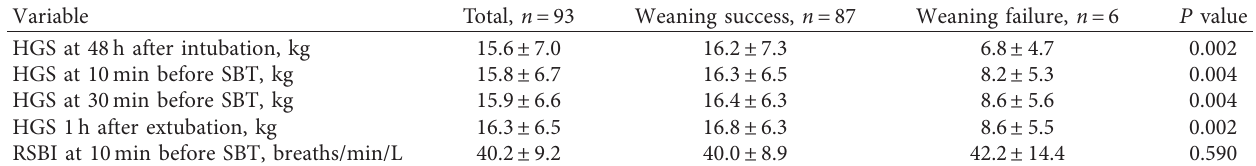
Table 2: Comparison of handgrip strength and rapid shallow breathing index between weaning success and weaning failure. Variable